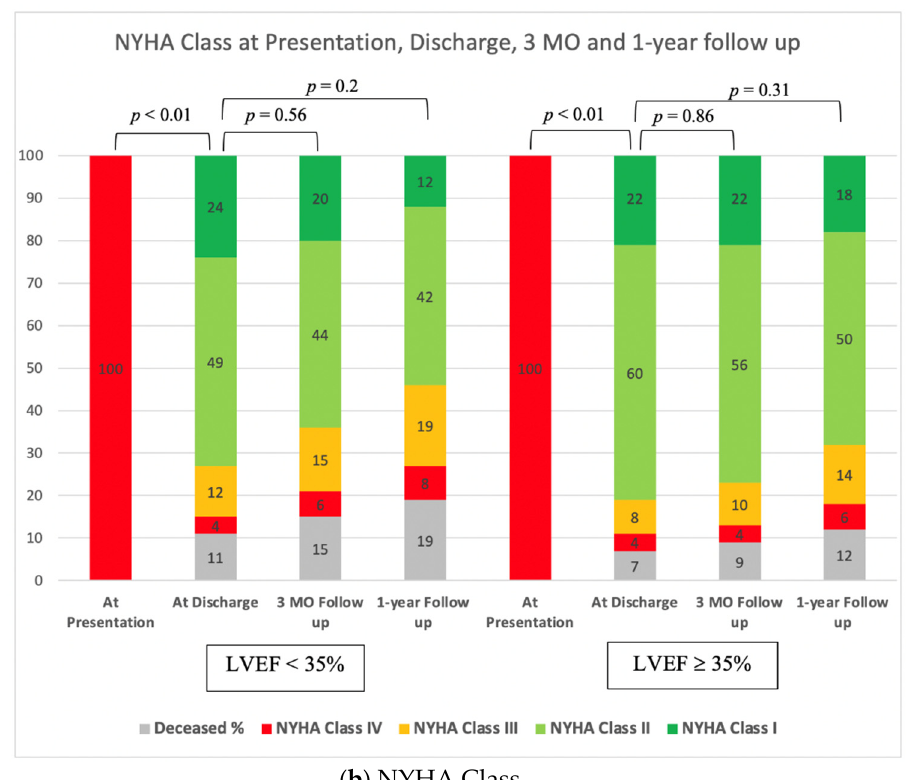
Figure 3. Clinical and Echocardiographic evaluation at presentation, discharge, 3-month and 1-year follow-up. ( a ) Systolic Pulmonary Artery Pressure (sPAP) was significantly reduced from presentation to discharge in both LVEF groups. sPAP reduction from presentation to 1-year follow up was consistent only for patients in the LVEF > 35%. ( b) NYHA class was significantly improved from presentation to discharge in both LVEF groups. NYHA class improvement remain consistent throughout follow-up in both groups; 36 out of 42 patients in the LVEF < 35% group and 51 out of 54 patients in the LVEF ≥ 35% group had NYHA functional class I or class II at 3-month follow